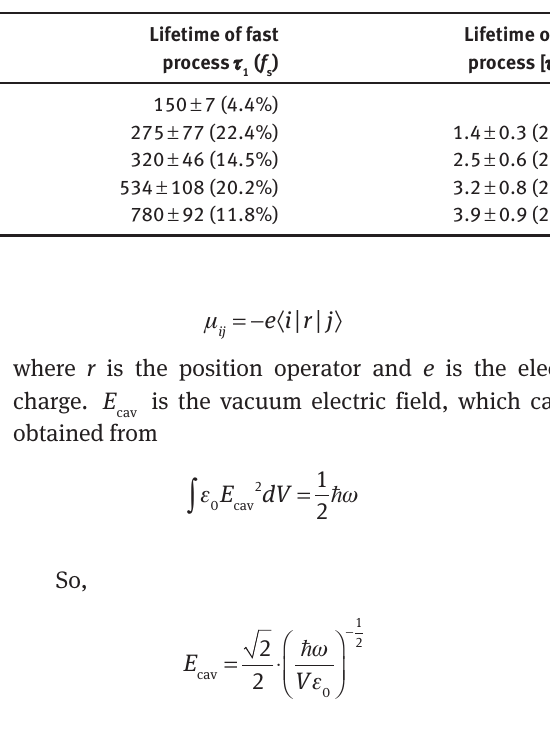
Table 1: Fitted lifetimes of monolayer graphene, silver nanowires, and the hybrid system consist of silver nanowires and graphene detected in the VIS and NIR,